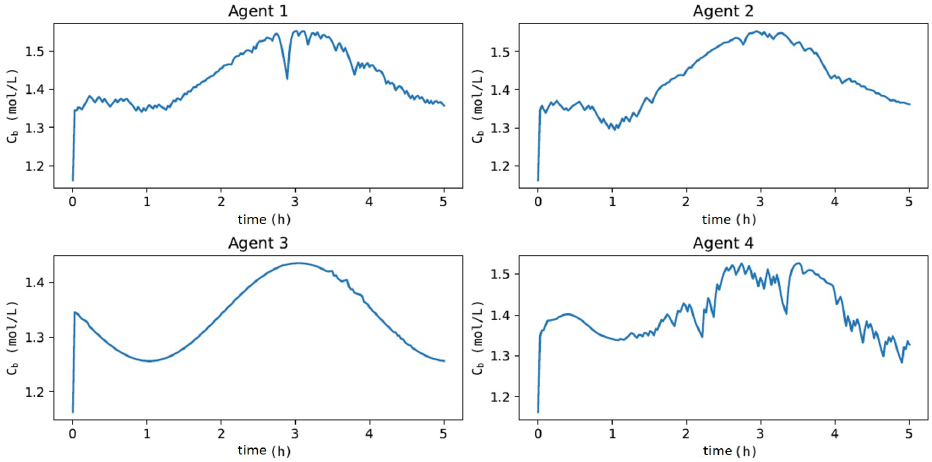
Figure 15. Dynamics of C b when subjected to process disturbances of Figure 14 over a 5 h control ex-